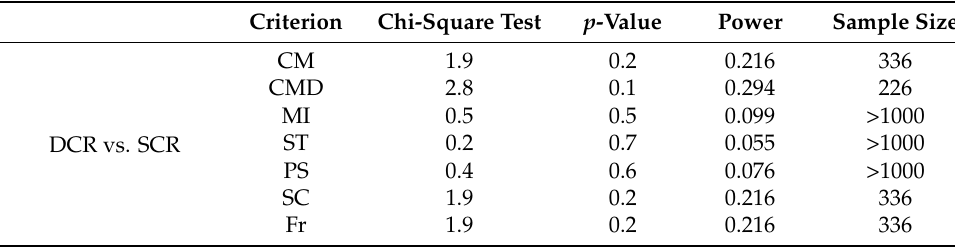
Table 6. The results of a log-rank test for comparing long-term results in a group with biological factors of caries risk (Group 2) between DCR and SCR restoration